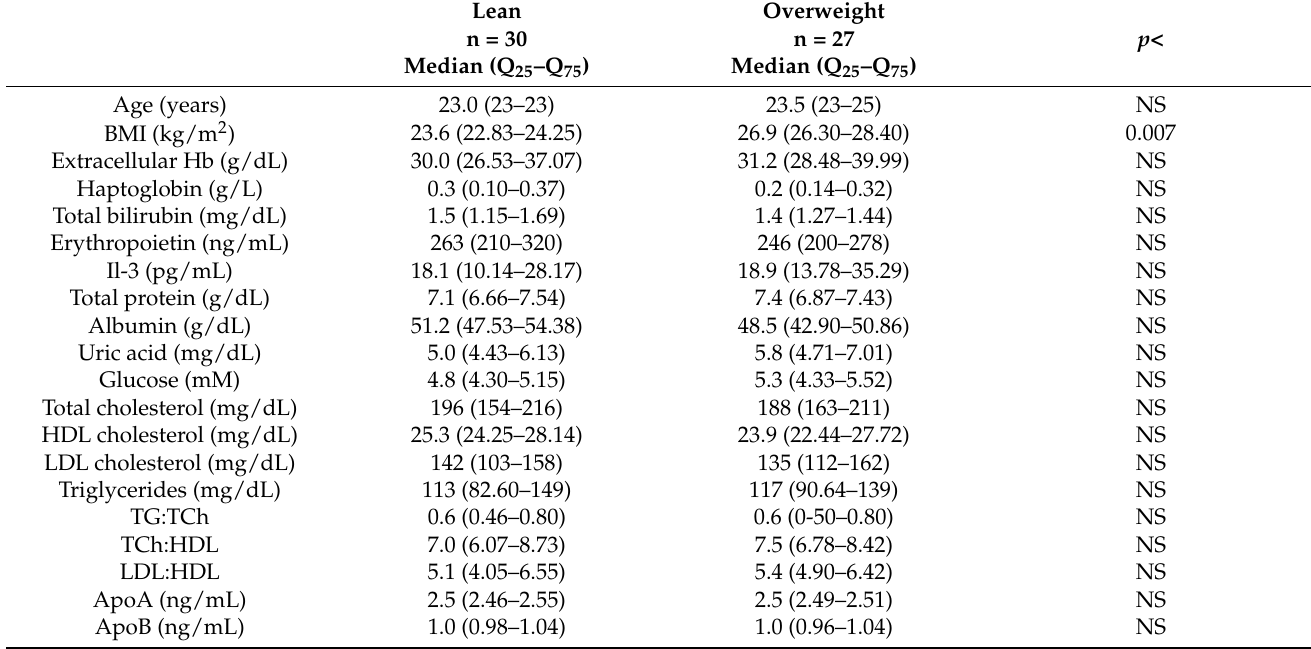
Figure 3. Box-whisker plot for HOMA-IR values in the study groups. * statistically significant difference at p < 0.05. Table 1. Anthropometrical and biochemical parameters in the study